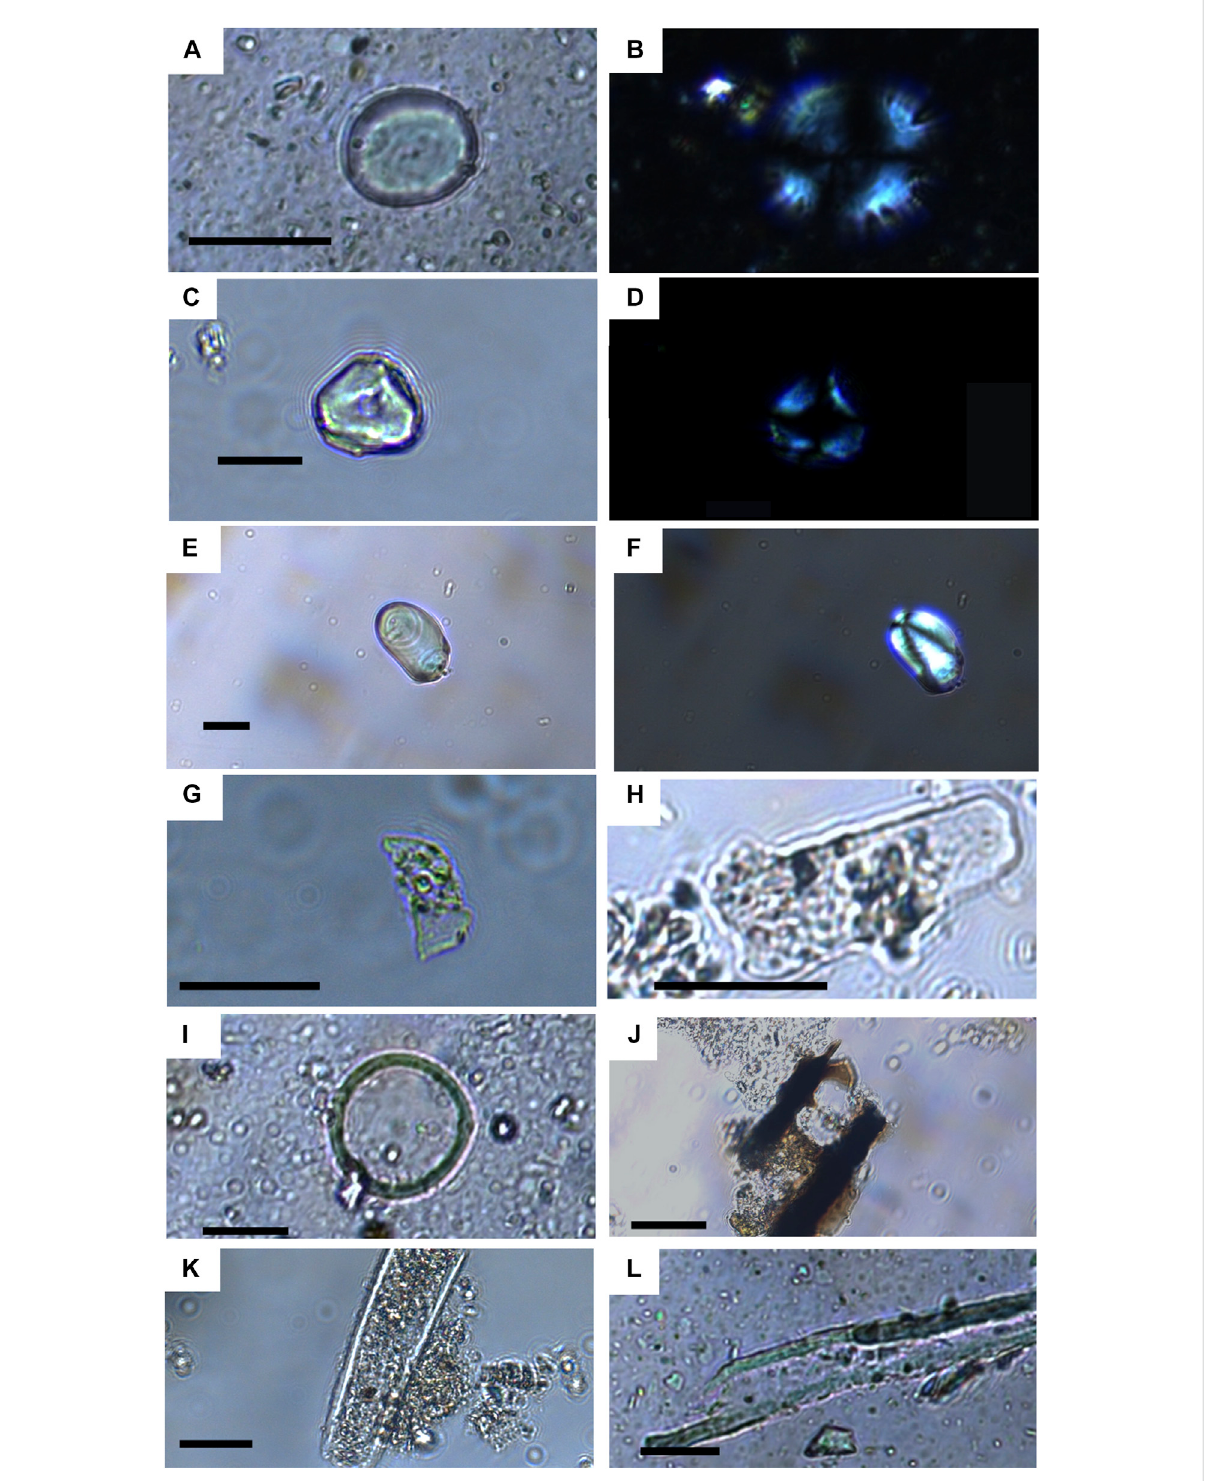
FIGURE 5 Micrographs of a selection of microremains. All scale bars represent 20 microns, (A) bright fi eld image of a lenticular starch in CB003, (B) cross- polarized image of the same starch, (C) bright fi eld image of faceted starch in CB003, (D) cross-polarized image of the same starch, (E) bright fi eld image of an eccentric starch in CB008, (F) cross-polarized image of the same starch, (G) trapezoidal (grass short-cell) phytolith in CB012, (H) elongate psilate thin phytolith, (I) indeterminate pollen from CB003, (J) charcoal particle in CB019, (K) broken probable non-human mammalian hair in CB003, and (L) plant fi ber in